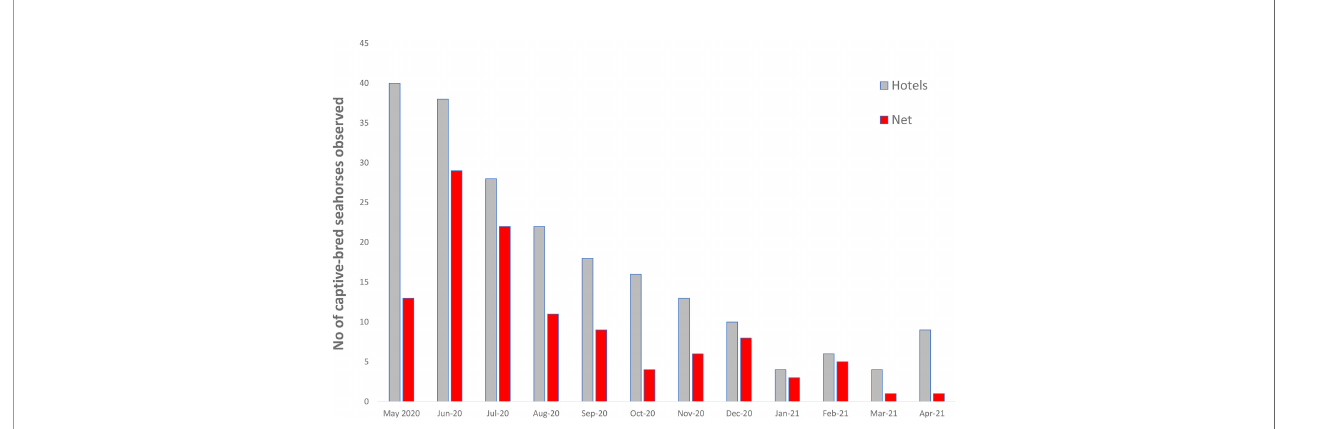
FIGURE 3 | Number of captive-bred Hippocampus whitei observed during each monthly survey from May 2020 to April 2021 on the protective swimming net and seahorse